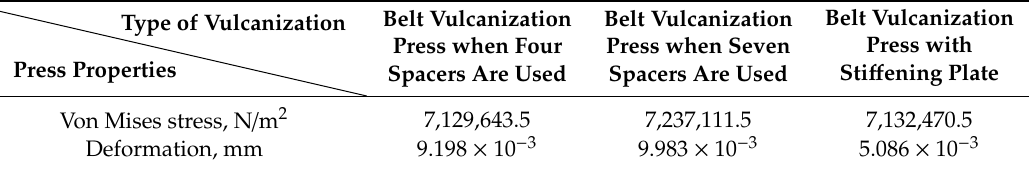
Table 5. Mises stress of the deformations for the belt vulcanization